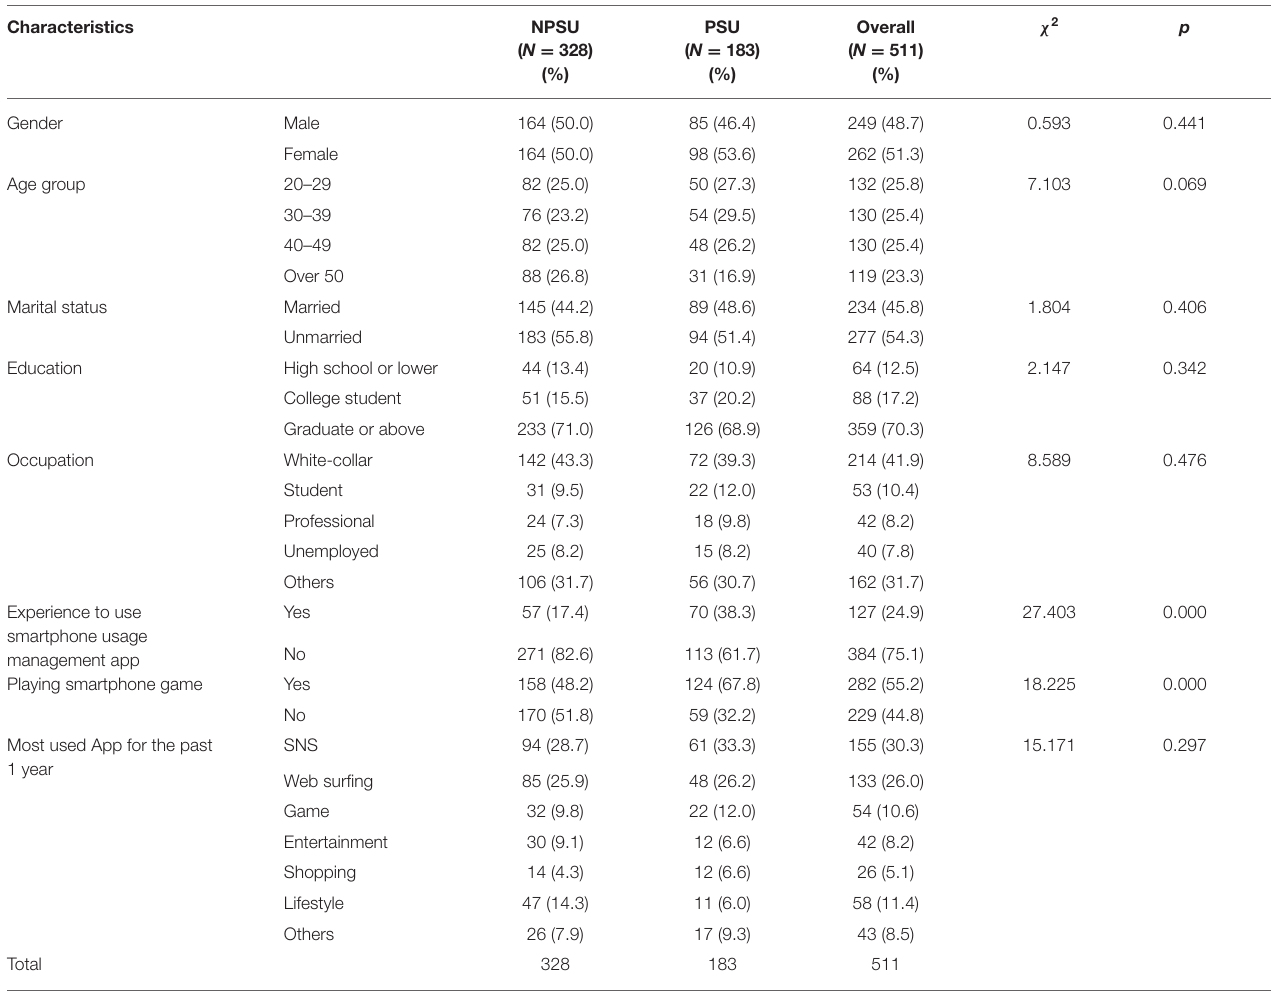
TABLE 1 | Characteristic of socio-demographics.